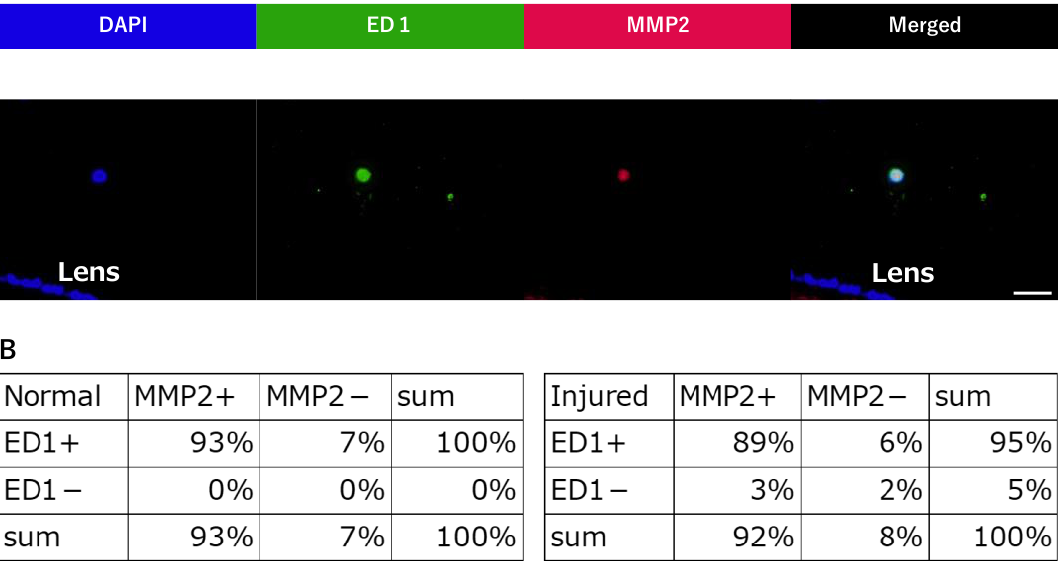
Figure 3. Quantification of ED1-positive and MMP2-positive cells infiltrated in Zinn’s zonule. ( A ) This image is in the injured group. Immunofluorescence observations (magnified 400×) were performed on paraffin sections. Nuclei were identified using DAPI (blue), macrophages using anti-ED-1 (green), and MMP2-positive cells using anti-MMP2 (red). Nucleated cells near the lens were counted and imaged to determine whether they were ED1-positive or MMP2-positive. The breakdown was counted. ( B ) The number of single-positive cells and double-positive cells for ED1 and MMP2 were counted and represented in the table. Scale bar: 20 μm. Four rat specimens were used for the normal and the injured groups, and three 5 μm sections were imaged from each specimen, for both groups. We observed Zinn’s zonule in two locations in each section.